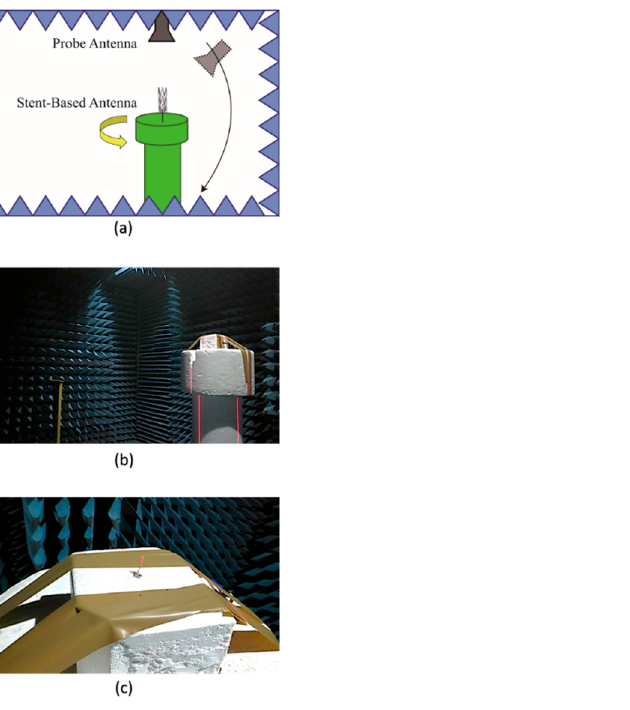
Figure 13. ( a ) Illustration of the measurement setup for 3D far-field radiation measurements, ( b ) The anechoic chamber, ( c ) The stent antenna mounted on a rotating stage to act as a receiving antenna.